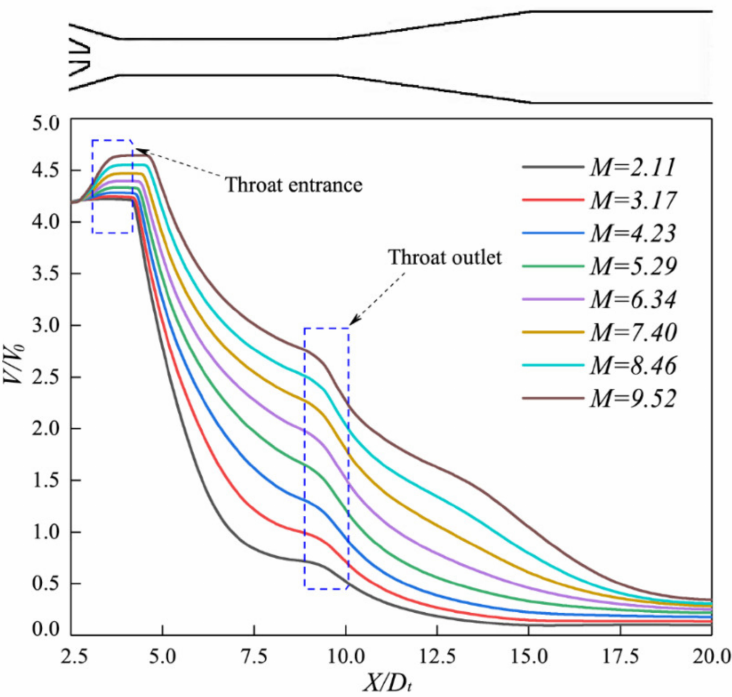
Figure 8. Velocity distribution of shaft axis from nozzle inlet to exit ( M = 2.11, 3.17, 4.23, 5.29, 6.34, 7.40, 8.46,